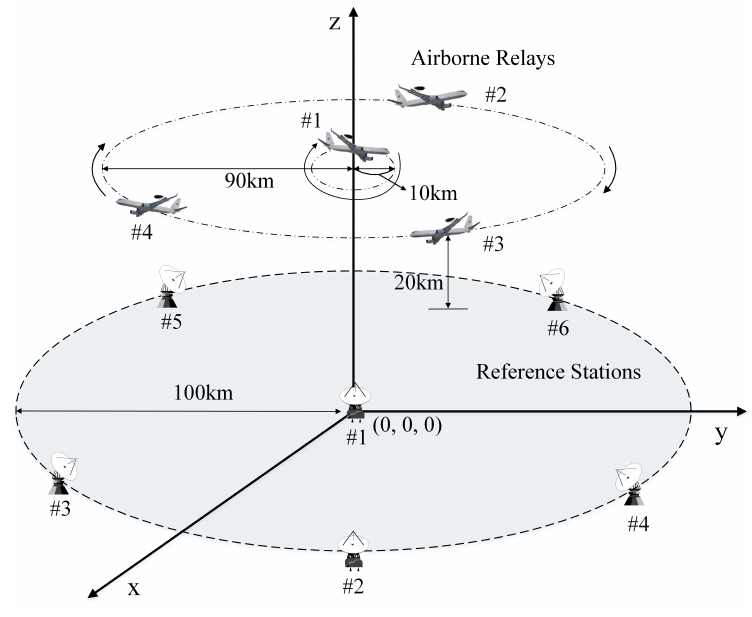
Figure 4. Segment disposition for